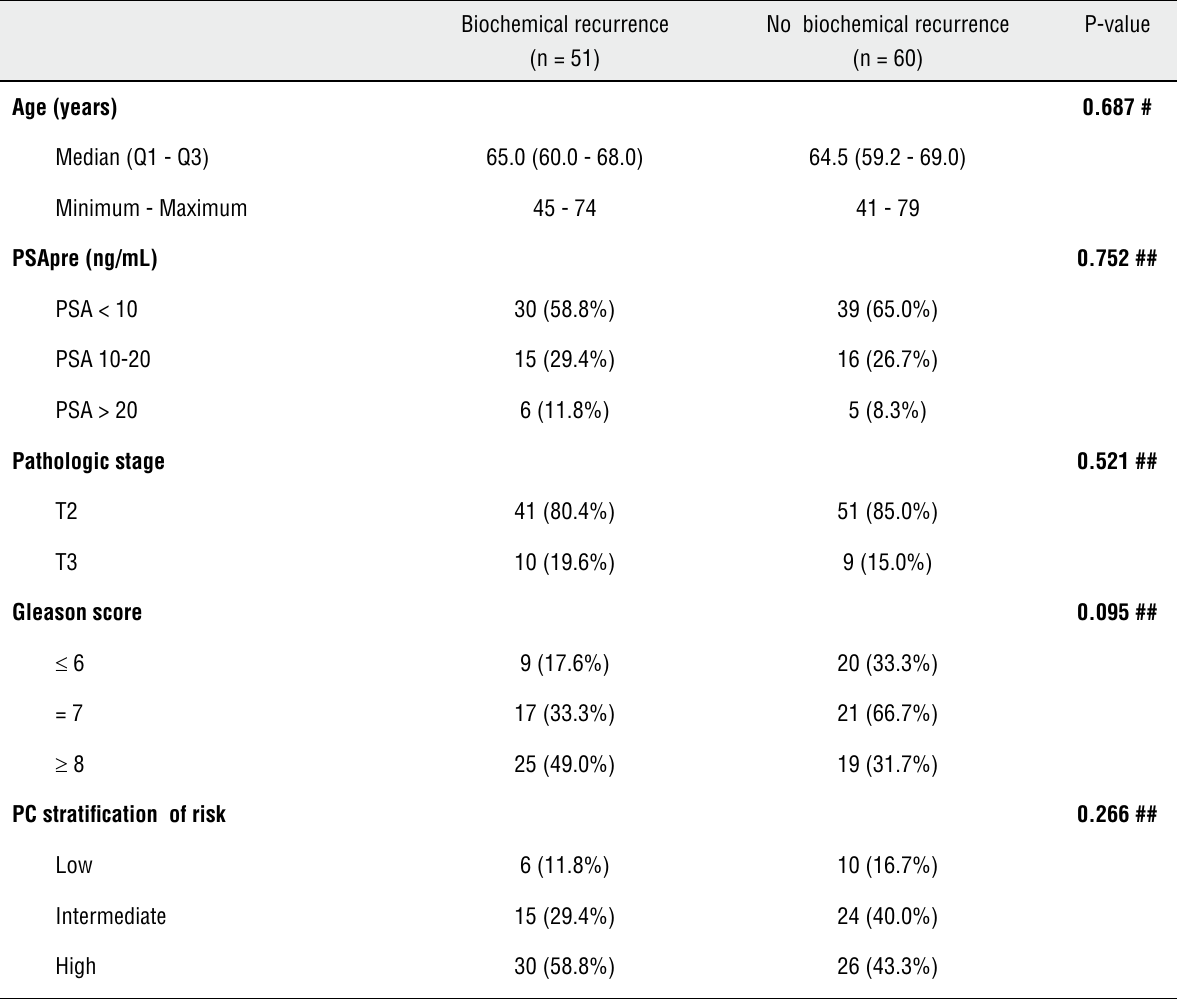
Table 1 - Demographic and clinical data: recurrence vs. no